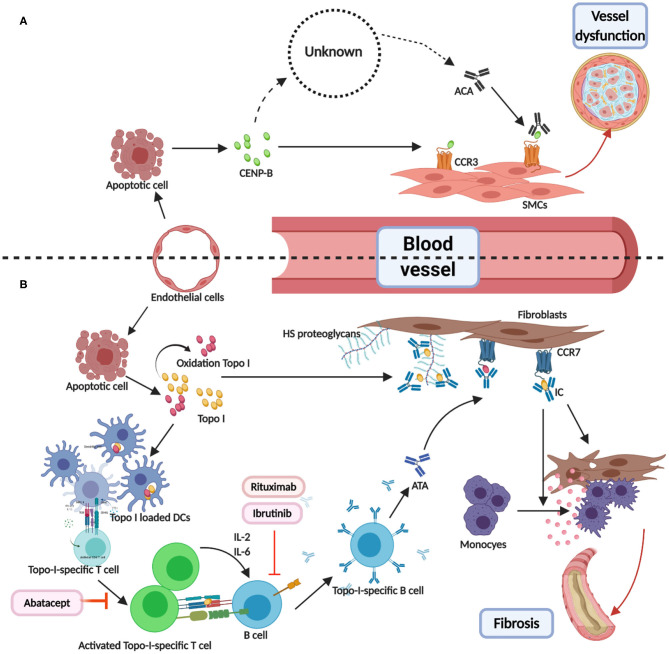
Direct combination of antibodies and antigens in systemic sclerosis. (A) CENP-B were released from the apoptotic ECs. Then, the extracellular CENP-B bound to the contractile-type PASMCs via CCR3. Next, the binding of CENP-B to the contractile SMCs stimulated migration in the wound healing assays. The exact way of production of ATAs was known. When combined with CCR3-binding CENP-B, ATAs may abolish vascular self-repair, further leading to angiopathy. (B) TOPO I was released from apoptotic ECs and some of them were oxidized to AOPP. Then, TOPO I was bound to the bystander fibroblasts via CCR7 or HS proteoglycans. DCs loaded with selected TOPO I could activate the intrinsic TOPO I–specific T cells. The activated special T cells produced IL-2 or IL-6 and communicated with B cells through the interactions of MHC-TCR and CD40-CD40L. T cell–dependent B cells were activated, thereby becoming TOPO I–specific B cells and resulting in ATAs. Binding TOPO I recruited circulating ATAs and composed ICs, which could induce the adhesion and activation of circulating monocytes. Abatacept-regulated dysfunction T cells. Rituximab and ibrutinib may be used as B-cell depletion therapy. CENP-B, centromere proteins B; EC, endothelial cell; PASMC, Pulmonary artery smooth muscle cells; CCR, CC chemokine receptor; SMC, smooth muscle cell; AOPP, advanced oxidation protein products; HS, heparan sulfate.